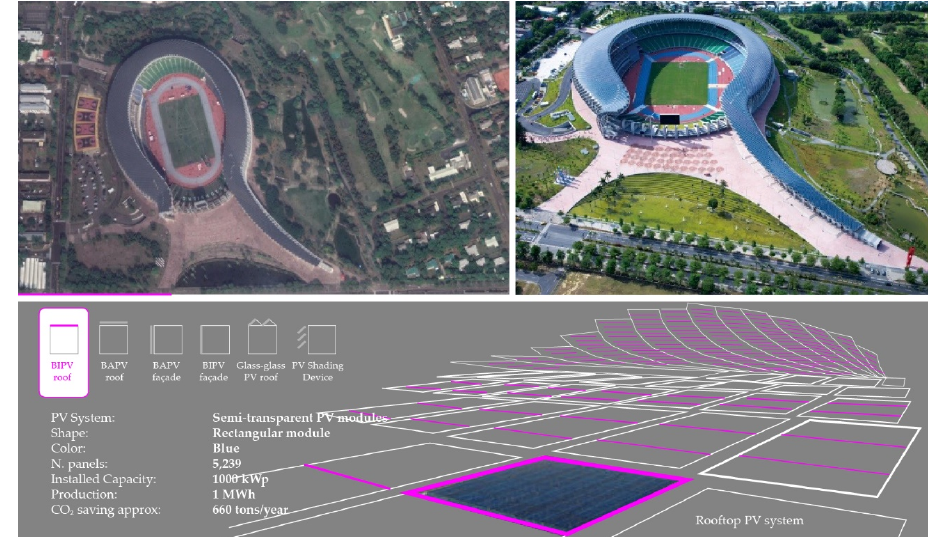
Figure 12. Kaohsiung National Stadium with the dragon shaped roof all covered by PV modules (top view of the stadium: Source illustration Google Earth, Google 2020, Maxar Technologies 2020 ( on top left :); view of the stadium: photo credits: CECI Engineering Consultant Inc., Taiwan) ( on the top right ); Integration and characteristic of PV systems ( on the bottom ).